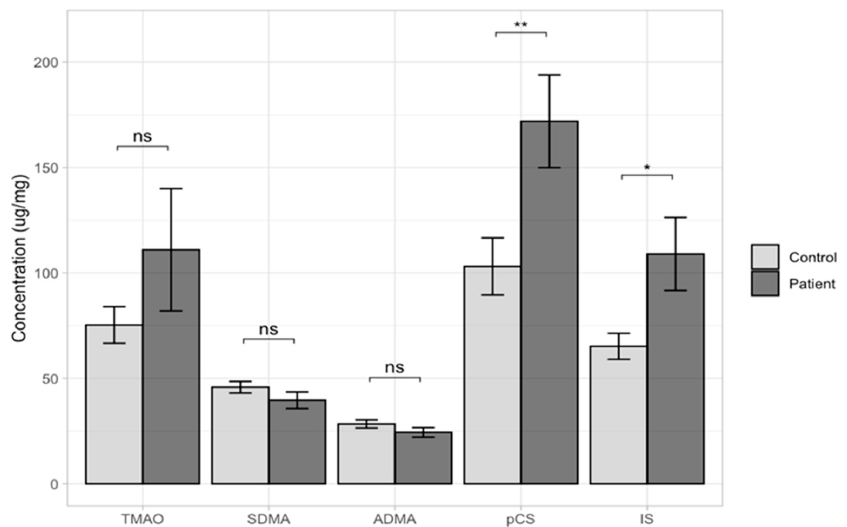
Figure 1. Determined levels of all uremic toxins in the study groups (ASD + HFA patients and controls). ns—not significant difference; *—statistically significant, with p < 0.05; **—statistically significant, with p < 0.001.